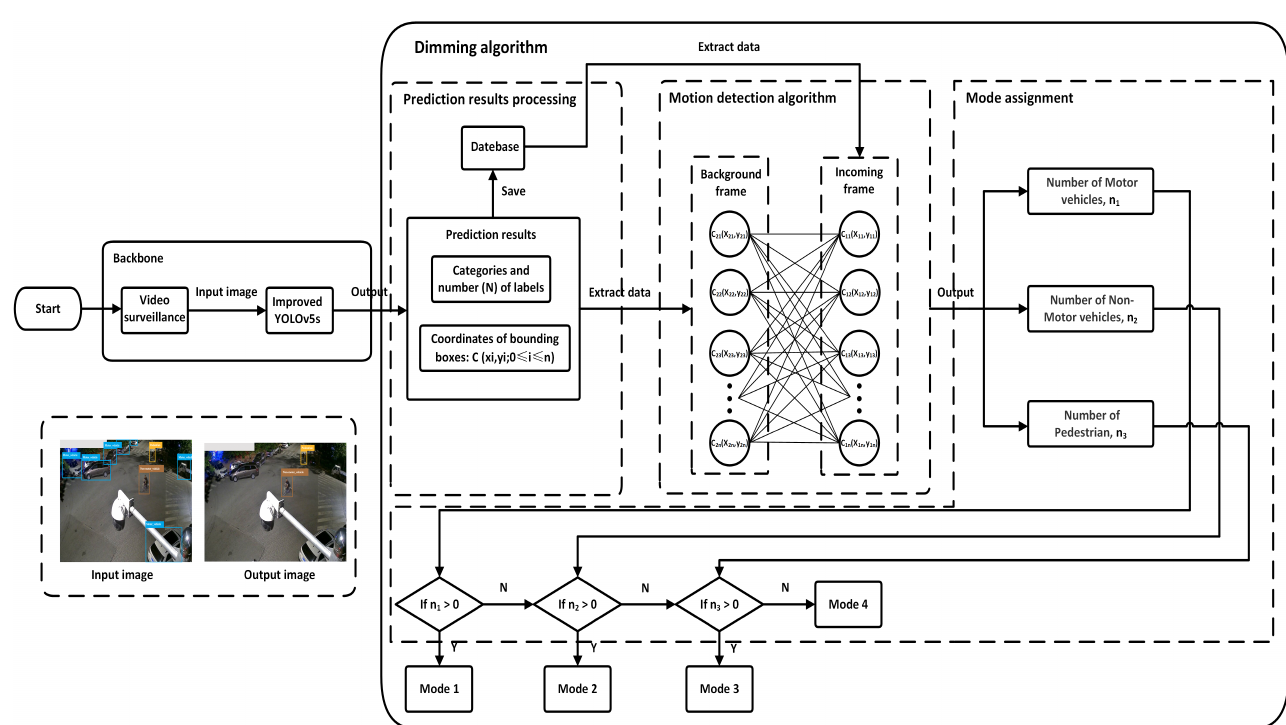
Figure 3. The proposed dimming method.